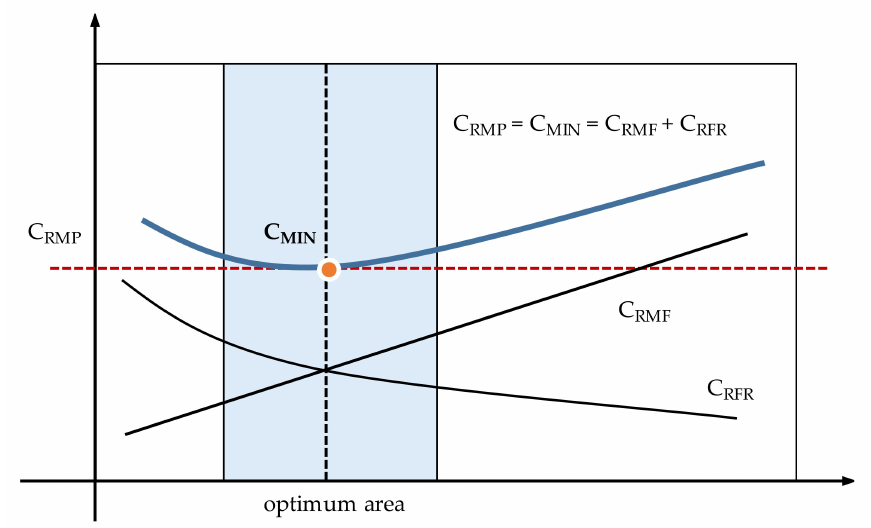
Figure 7. Risk management